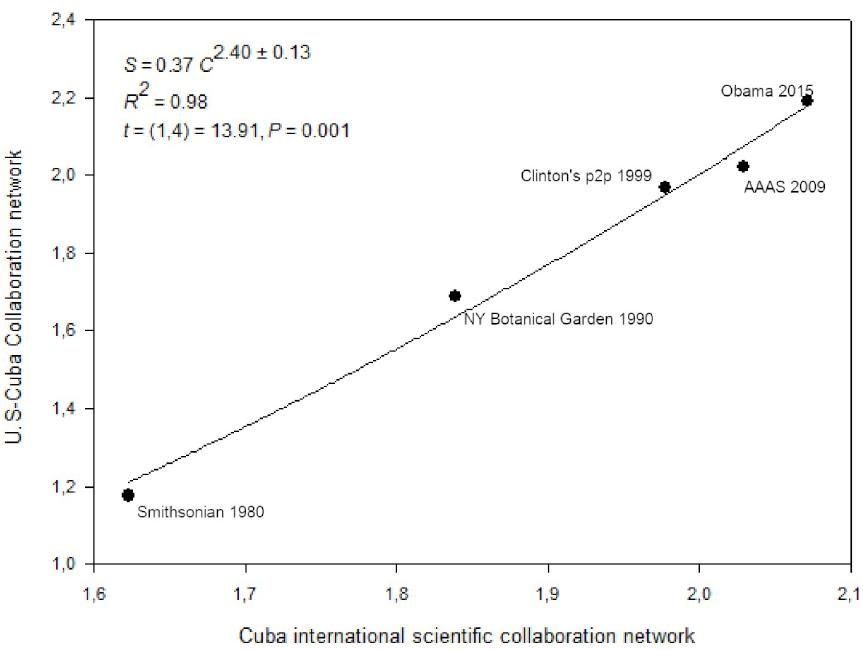
Fig 4. The scaling relationship between the size of the Cuban international collaboration network and the size of the Cuba–U.S. collaborative network. X = the number of countries in the overall Cuban international scientific collaboration, excluding the U.S. Y = the number of countries in the Cuba–U.S. collaboration network.